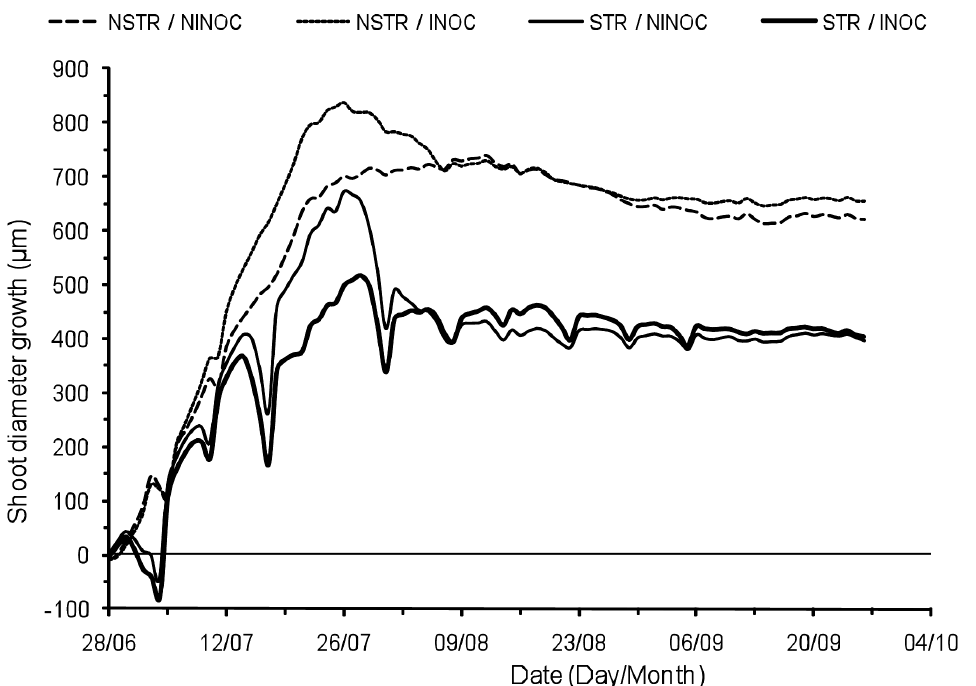
Figure 1. Shoot diameter growth (taken daily at 06:00 hours) of one-year old grapevines ( Vitis vinifera cv. Tempranil- lo) inoculated with Eutypa lata or left uninoculated and subjected to one of two watering regimes. INOC, inoculated with E. lata ; NINOC, non-inoculated, STR, water-stressed, NSTR, non-stressed. as identified by the staining of vascular tissues, ranged from 5 to 37 mm in inoculated vines, and from 0 to 3 mm in control vines. The mean ex- tent of necrosis in stressed and inoculated vines was 20 mm and in non-stressed and inoculated plants was 15 mm, but this difference was not significant (Table Table 3. Mean values of stomatal conductance and leaf water potential taken every 7–14 days, and shoot diameter growth and extent of necrosis taken at the end of the experiment, in one-year old grapevines ( Vitis vinifera cv. Tem- pranillo) inoculated with Eutypa lata or left uninoculated and subjected to one of two watering regimes for 4 months.